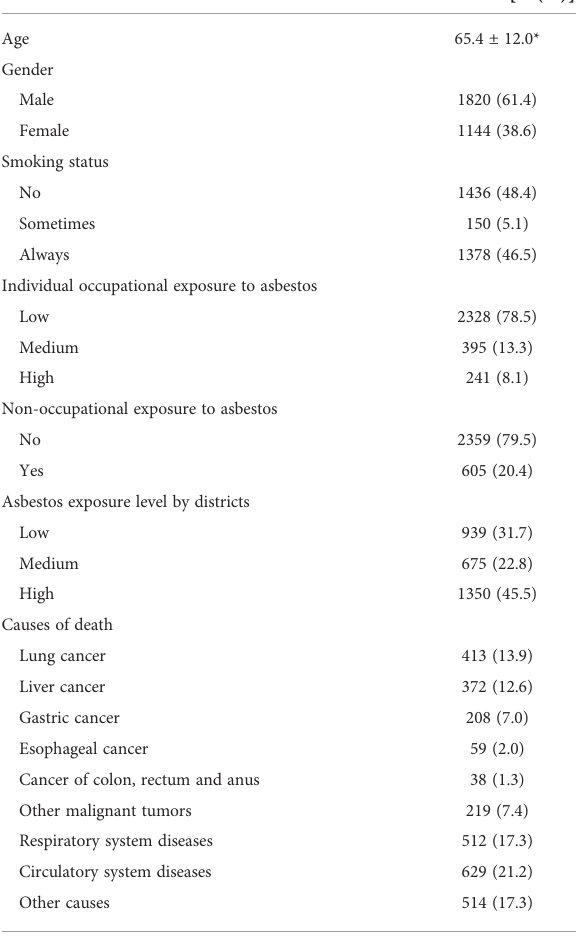
TABLE 1 Social demographic characteristics and causes of death among the study